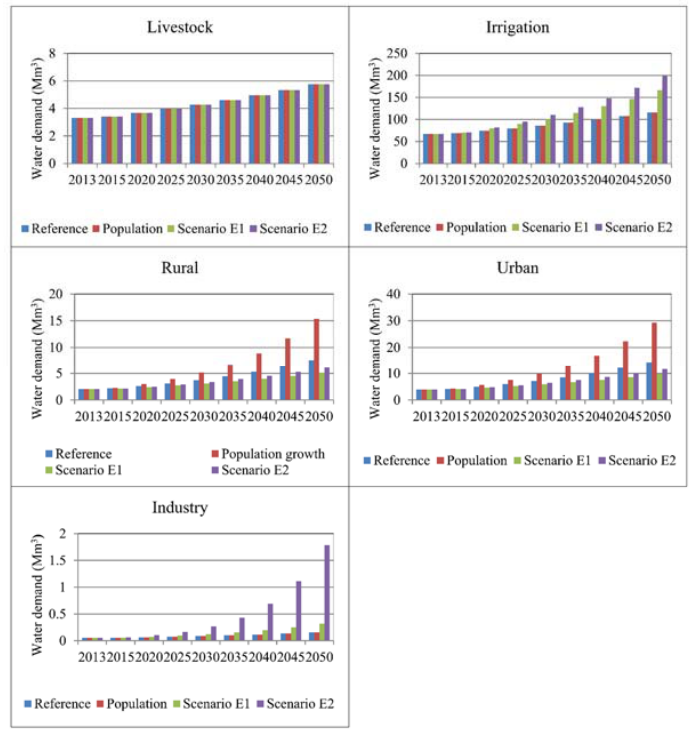
Figure 8. Water demand per sector in million cubic meters for three scenarios reference, scenario E1 (medium economic growth), and scenario E2 (high economic growth).